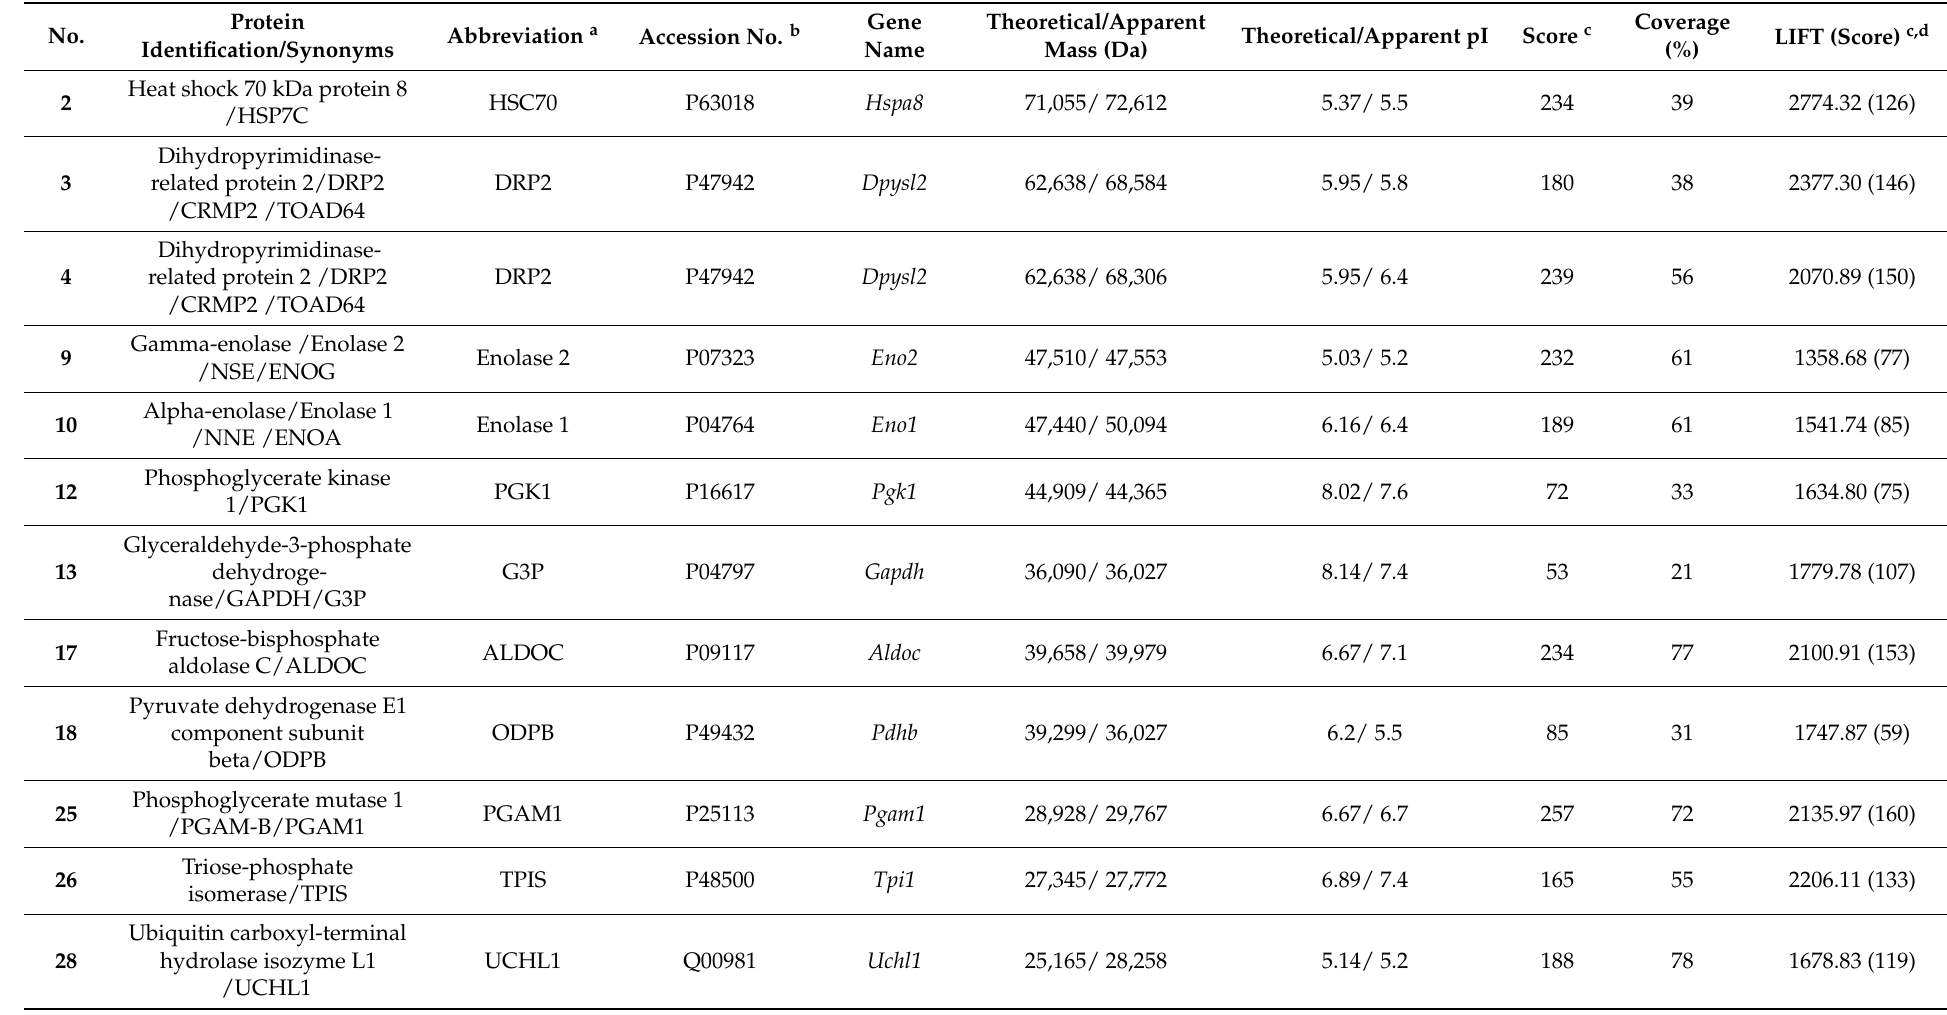
Table 1. 4E-BP2-interacting proteins identified by MALDI-TOF MS with significant changes in response to IR